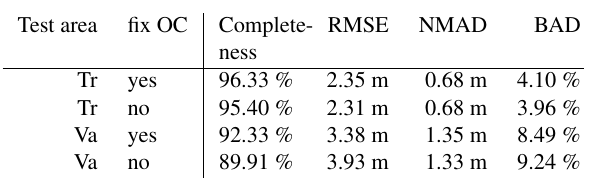
Table 2: Results for SGM with 16 directions with and without over-counting (OC) correction evaluation on the Cartosat-1 stereo pair. The BAD column gives the percentage of pixels with errors > 10 m.